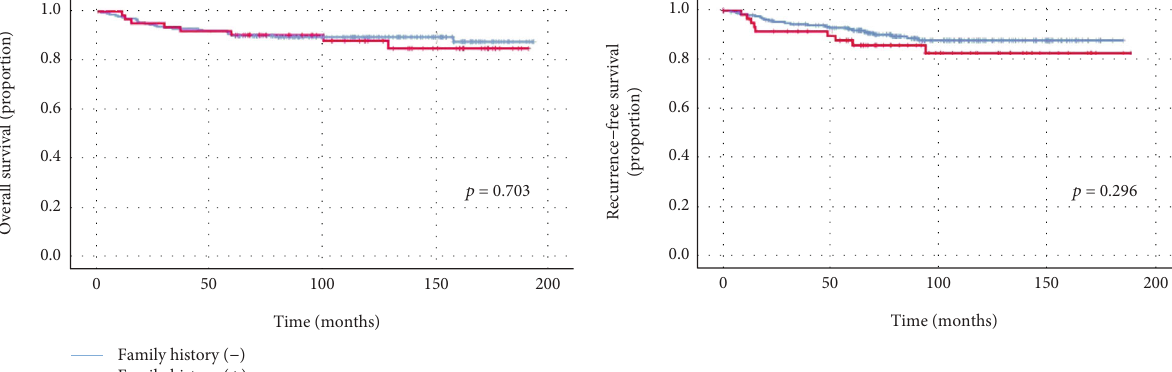
Figure 2: Survival curves of patients with family history and without family history.